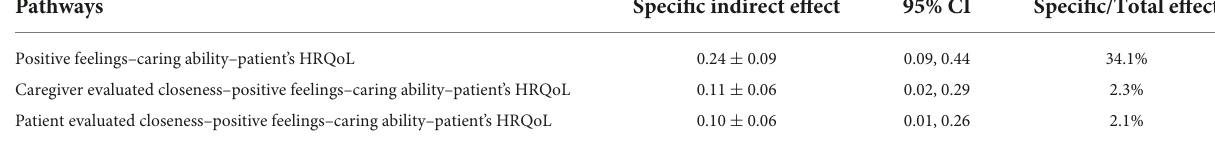
TABLE 3 Bootstrap method evaluated mediation effect and significance of three pathways.